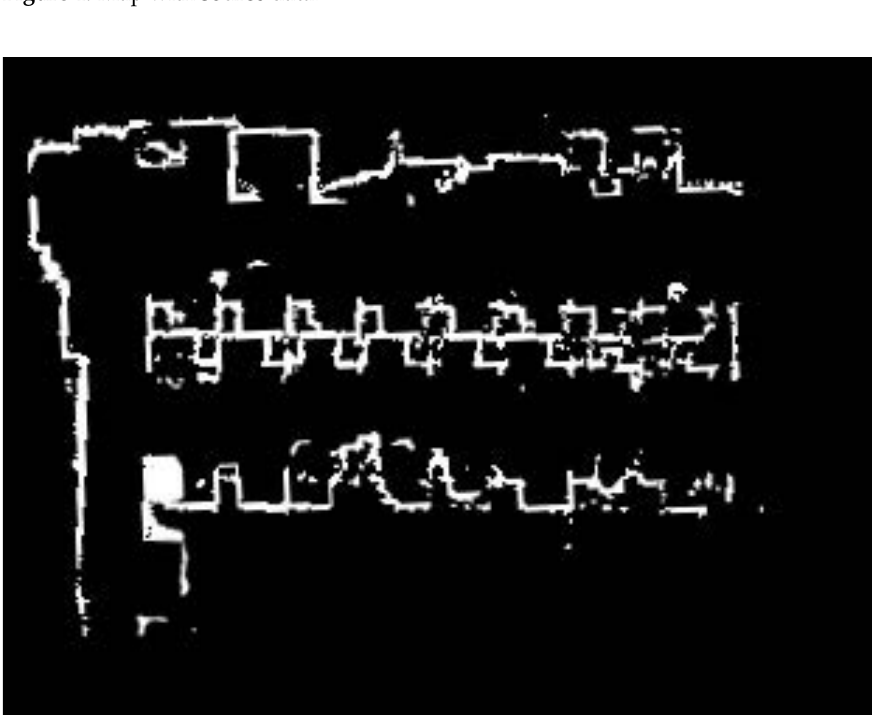
Figure 5. Map with filtered